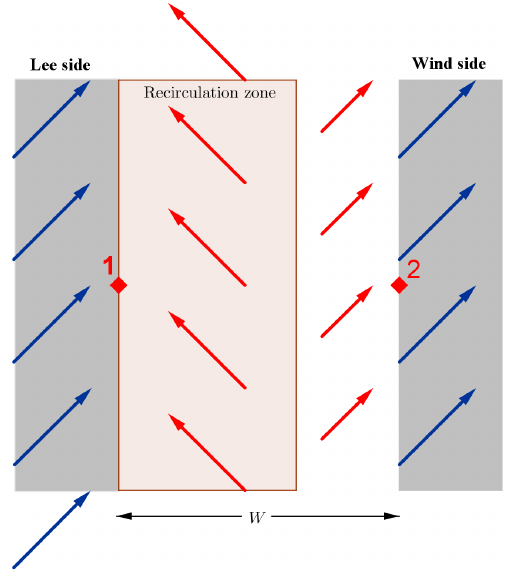
Figure 4. Schematic view of a street canyon seen from the top. The arrows represent the wind directions as modelled in OSPM. The length of the arrows are not proportional to the wind speed. The blue arrows are rooftop wind directions and the red arrows are street level wind directions. The receptors are marked with red diamonds.